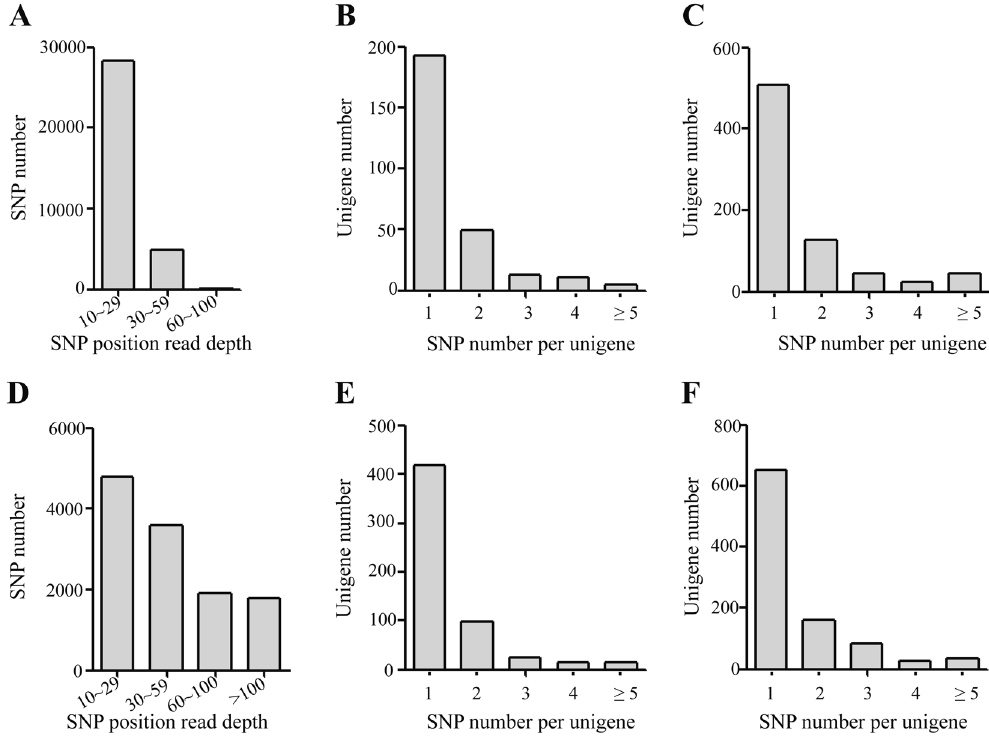
Figure 2. Read depth and distribution of SNPs. ( A ) and ( D ) represent read depths at SNP positions in transcriptomes in individuals and cell lines, respectively. ( B ) and ( C ) stand for SNP distribution in resistant and susceptible individuals, respectively. ( E ) and ( F ) represent SNP distribution in resistant and susceptible cell lines, respectively.